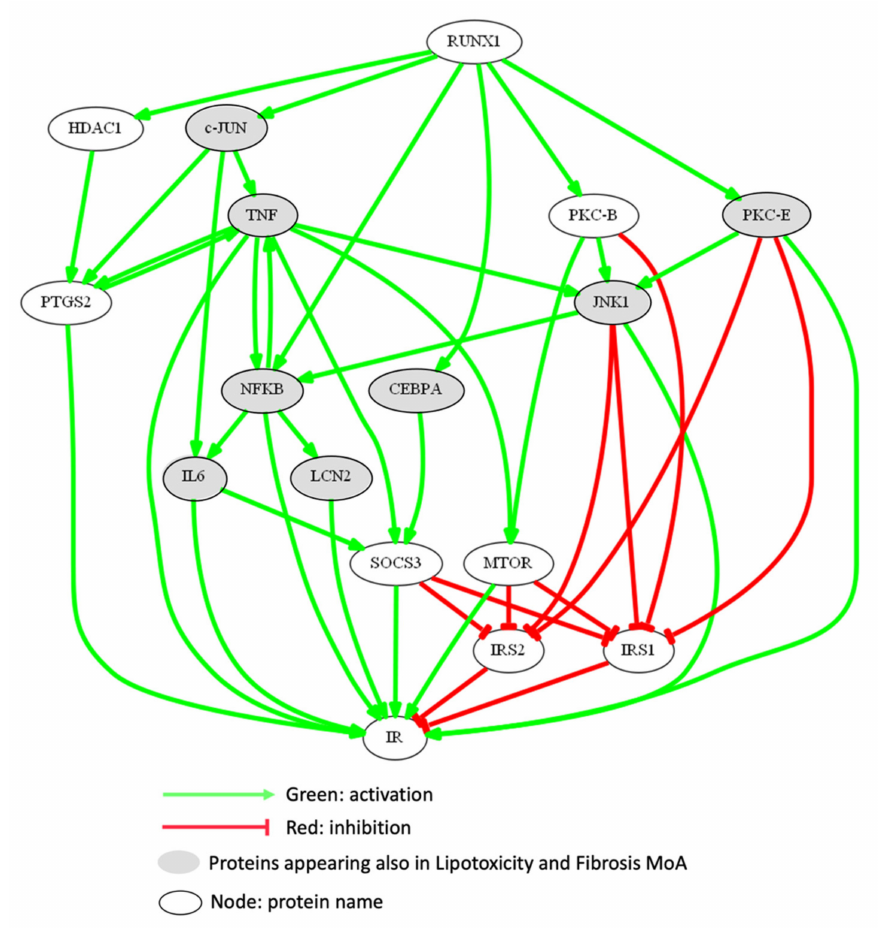
Figure 2. Most represented MoA of RUNX1 promoting IR in NAFLD in the population of TPMS model solutions. Gene names are used in the representations. RUNX1, runt-related protein 1; HDA1C, histone deacetylase 1; PTGS2, prostaglandin G/H synthase 2; c-Jun, protein encoded by JUN gene; TNF, tumour necrosis factor; NF κ B, nuclear factor kappa B; IL6, interleukin 6; LCN2, neutrophil gelatinase-associated lipocalin 2; CEBPA, CCAAT/enhancer-binding protein beta; SOCS3,